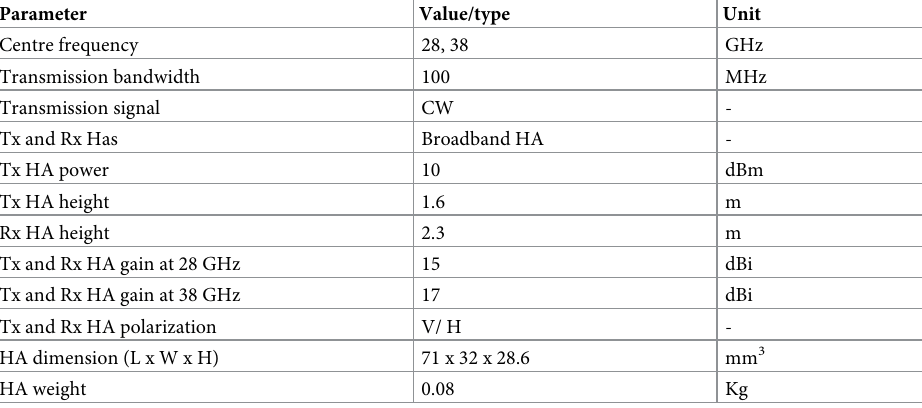
Table 1. Parameter specifications of the channel